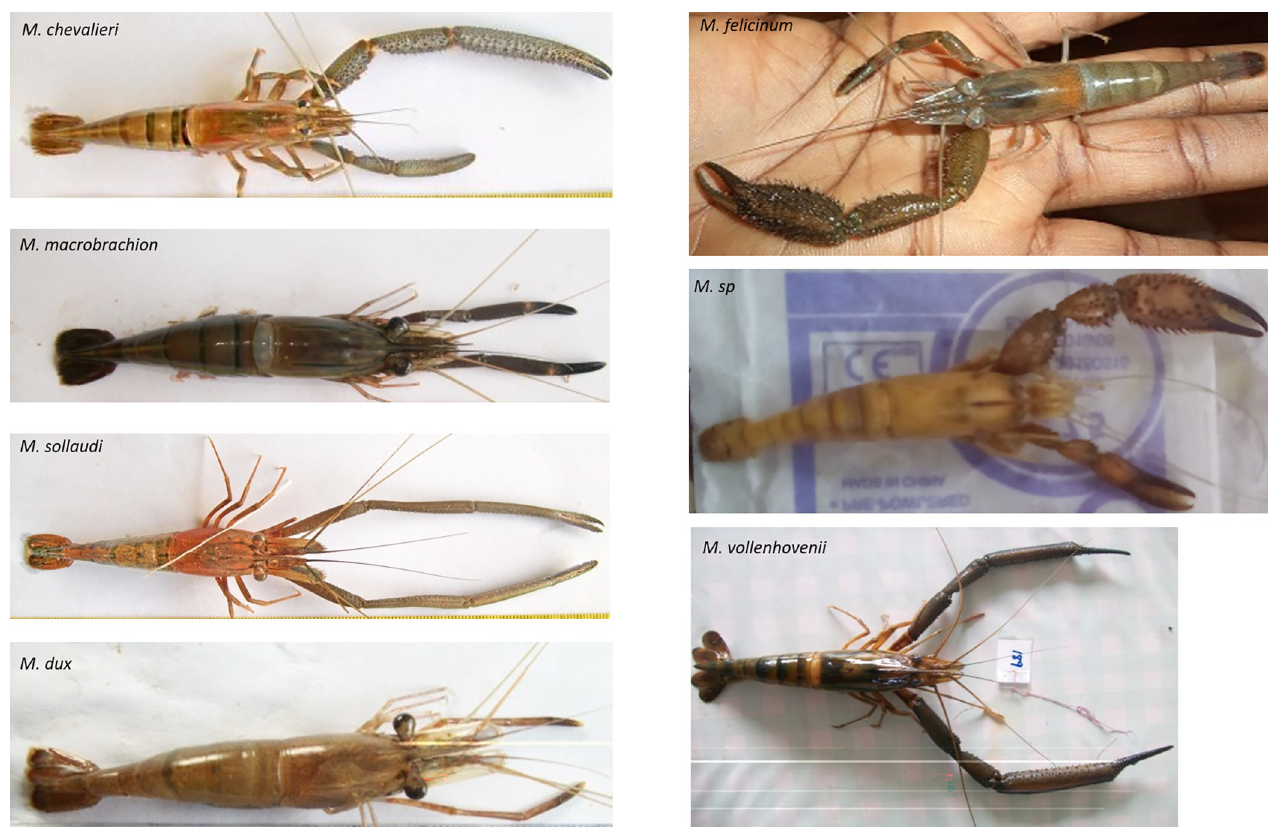
Fig 1. Pictures of seven Macrobrachium species in the coastal area of Cameroon identified based on morphological analysis using [10, 31] keys.